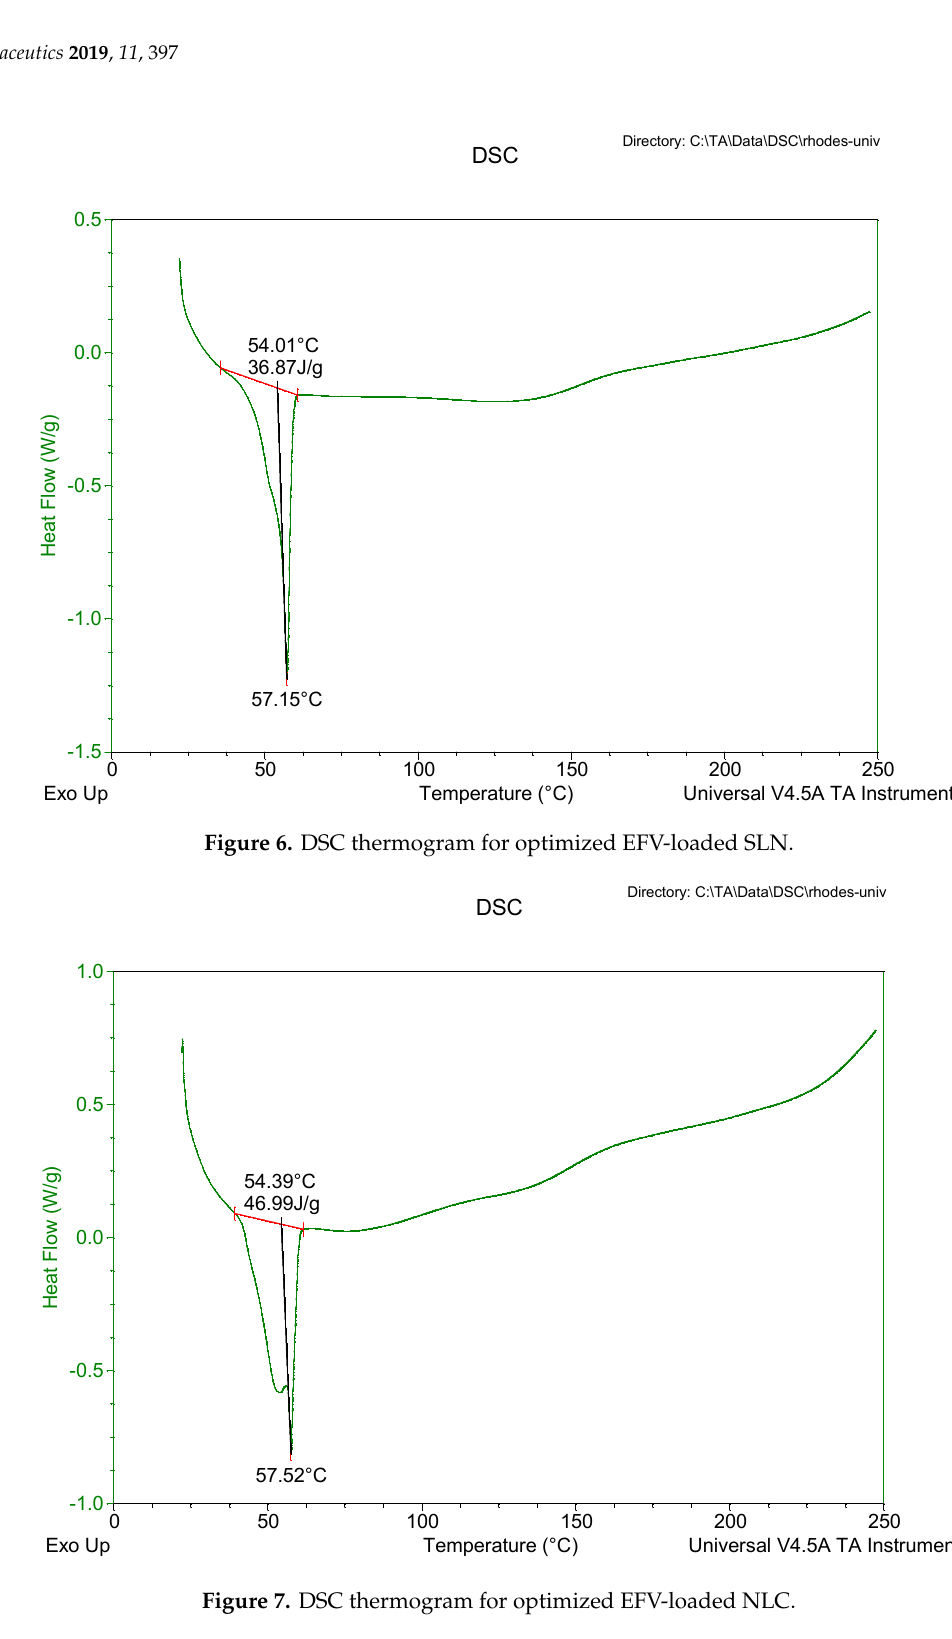
Figure 7. DSC thermogram for optimized EFV-loaded NLC .